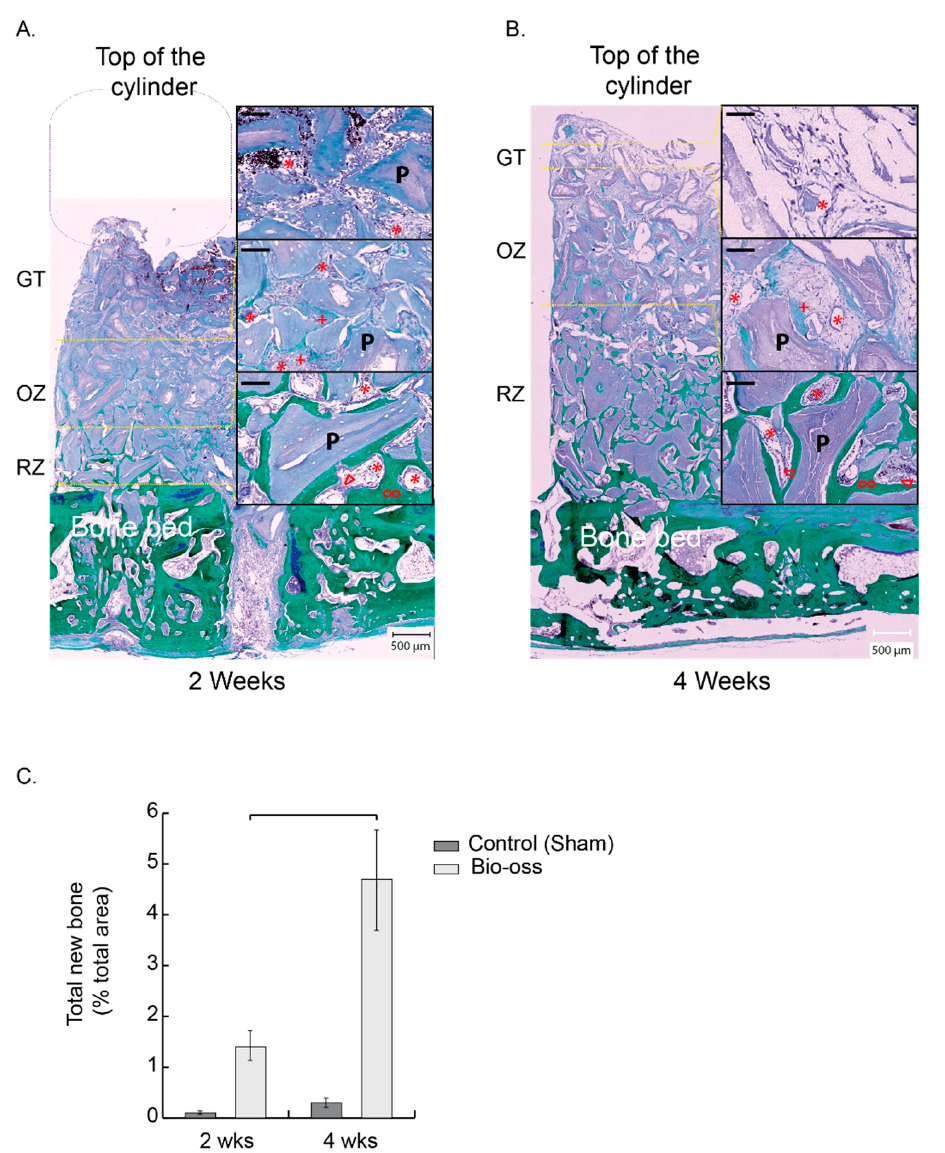
Figure 2. Description of the dynamic and controlled model of osteogenesis. ( A , B ) New bone development in a representative entire cylinder content filled with BO at 2 weeks ( A ) and 4 weeks ( B ): Left panels: whole cylinder content—Right panels: magnifications from the delimited zones RZ, OZ, and GT (yellow dotted lines). RZ is the remodeling zone in which new bone trabeculae (green, ∞ ) surround the particles (purple, P) and are lined by osteoblast rows ( ∆ ) and a rich vascularized (*) fibroconnective tissue. OZ is the osteogenic zone, a fibroconnective tissue and an osteoid tissue, highly vascularized, in which the matrix is being mineralized and appears in light green (+). GT is the granulation tissue that migrates to the top of the scaffold over time, dragging the OZ and the RZ. At 2 weeks, a missing part from the scaffold, not colonized by cells, was detached and is figured by a purple rounded square. Black bars in the magnifications: 100 µm. ( C ) Total new bone measured in the whole cylinder (% total area) at 2 and 4 weeks. Bio-Oss n = 6 at 2 and 4 weeks (dark grey), control (sham) n = 4 at 2 and 4 weeks (light grey), results expressed as mean +/ − sem. Bracket p < 0.05.